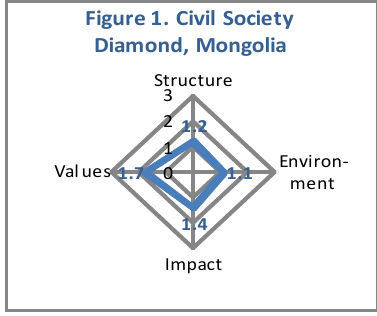
Figure 1. Civil Society Diamond,